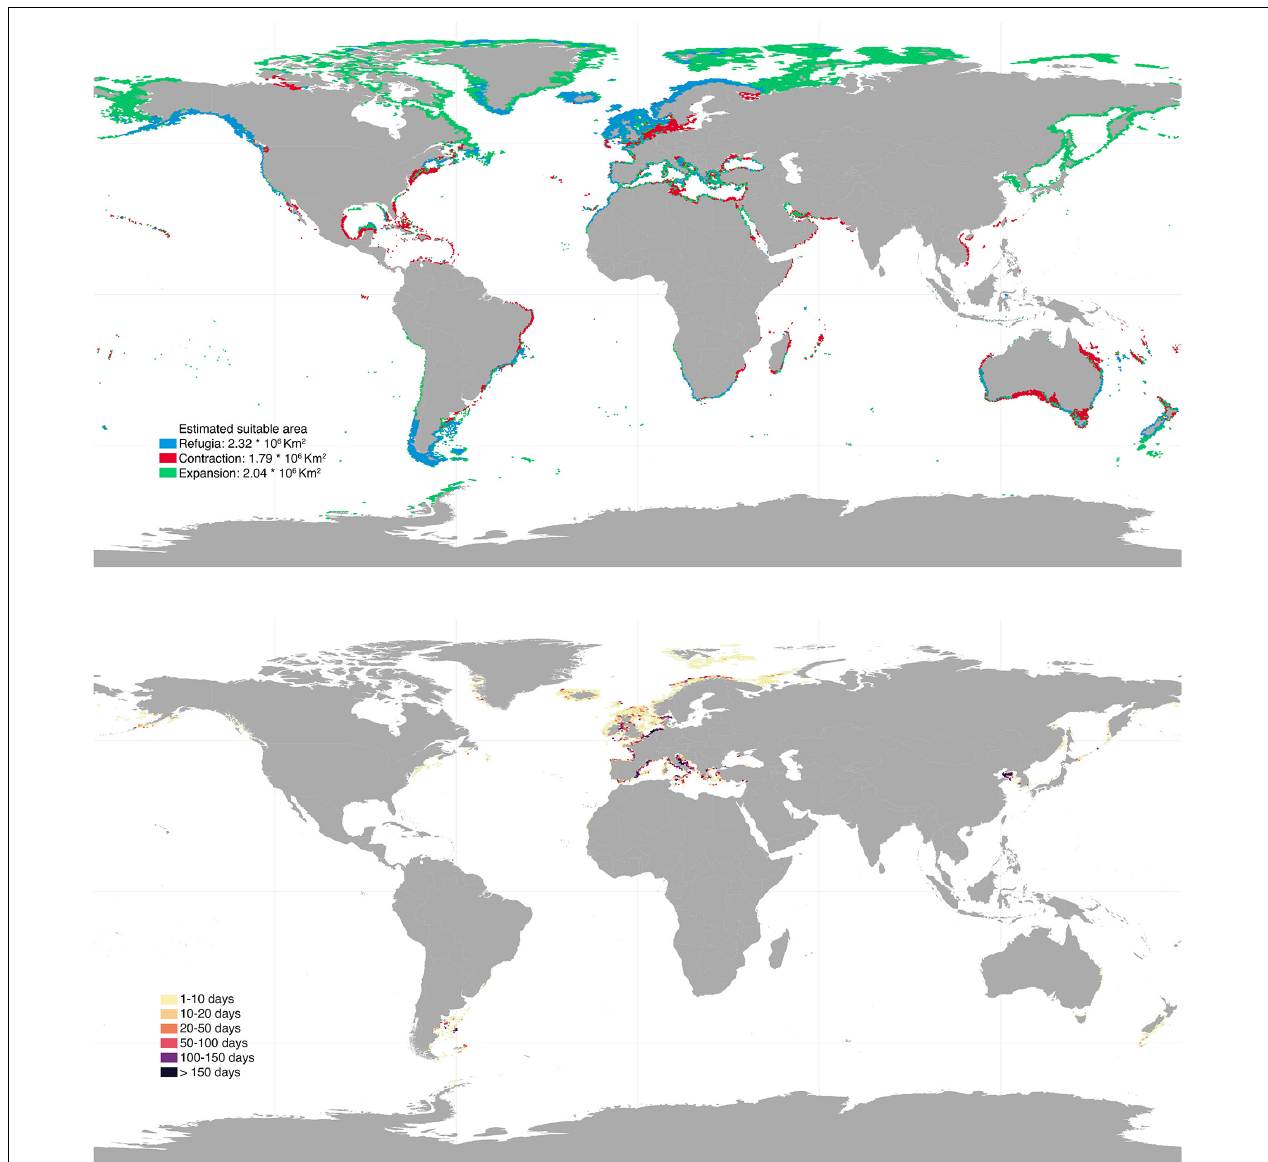
FIGURE 4 | Upper panel: global projected future distribution for rhodoliths under RCP 8.5 scenario. Blue, red, and green colors depict regions of refugia, range contraction and range expansion, respectively. Bottom panel: bottom trawling intensity (days per year) overlaying rhodolith suitable habitats under RCP 8.5. Results were aggregated for better visualization. High resolution maps can be found in Supplementary Material